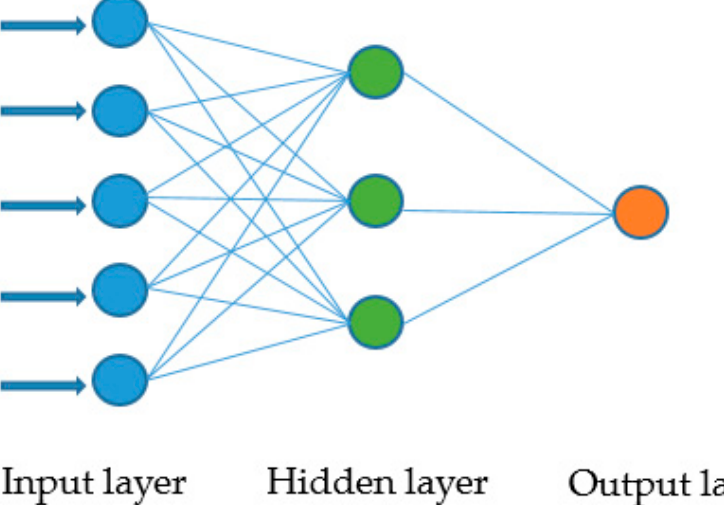
Figure 5. Diagram of a fully connected artificial neural network (ANN) with one hidden layer and a single output value.